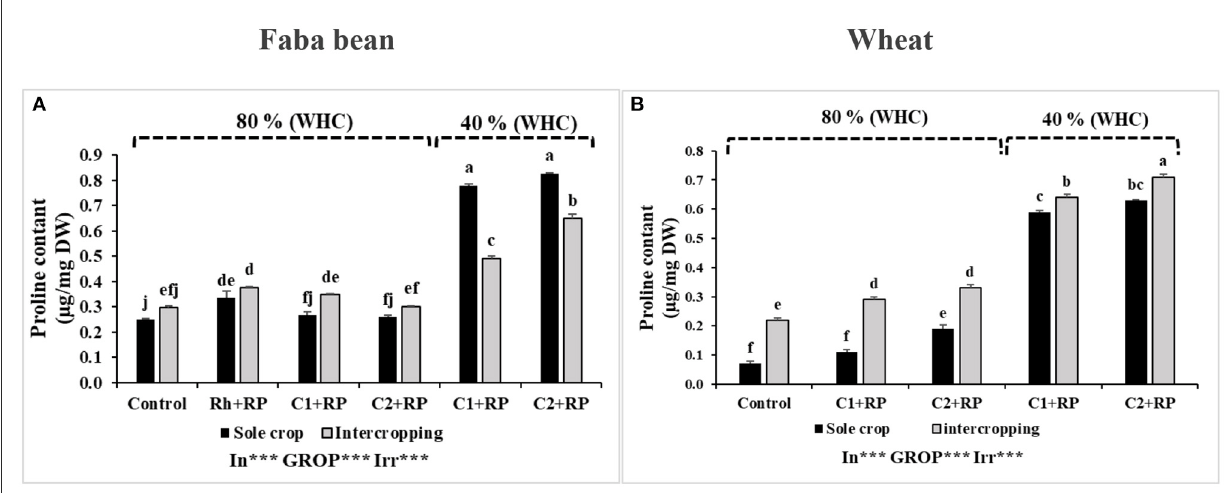
FIGURE5 Proline content in faba bean (A) and wheat (B) grown as a sole crop or intercropped under water sufficiency and P limitation (80% WHC, RP) vs. combined water deficit and P limitation (40% WHC, RP) and inoculated with two rhizobacterial consortia (C1 and C2) containing rhizobia and two PGPRs. The positive controls were supplemented with 125 µ mol/l of KH 2 PO 4 and 46 mg/l of KNO 3 (control). The negative controls received RP and were inoculated with the rhizobia only (Rh + RP). Each value represents the mean ± standard error (SE) of three replicates (In, inoculation; GROP, type of cropping; Irr, irrigation). Values with different letters are significantly different at 0.05 level of probability by Student-Newman-Keuls. * Represent the significance level of